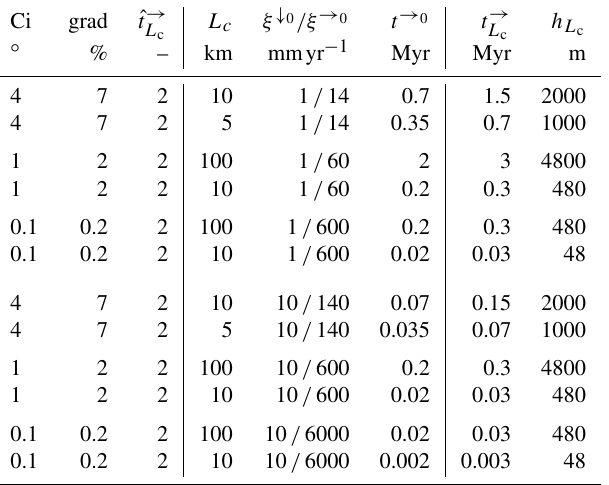
Table 2. Example model parameters and predicted timescales for η = 1 and µ = 1 and for selected values of dimensionless erosion 2 4 rate Ci and domain length scale L c